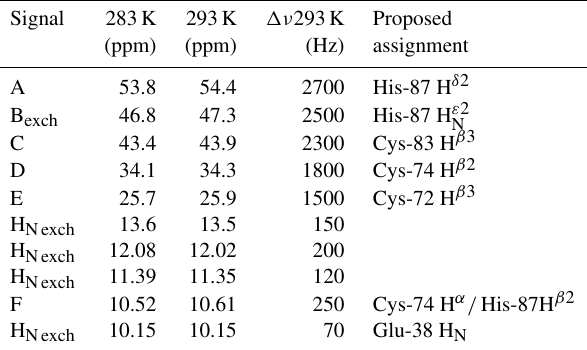
Table 1. Chemical shifts and line widths of the paramagnetic 1 H NMR spectrum of oxidized MitoNEET, recorded at 600MHz, and the proposed signal